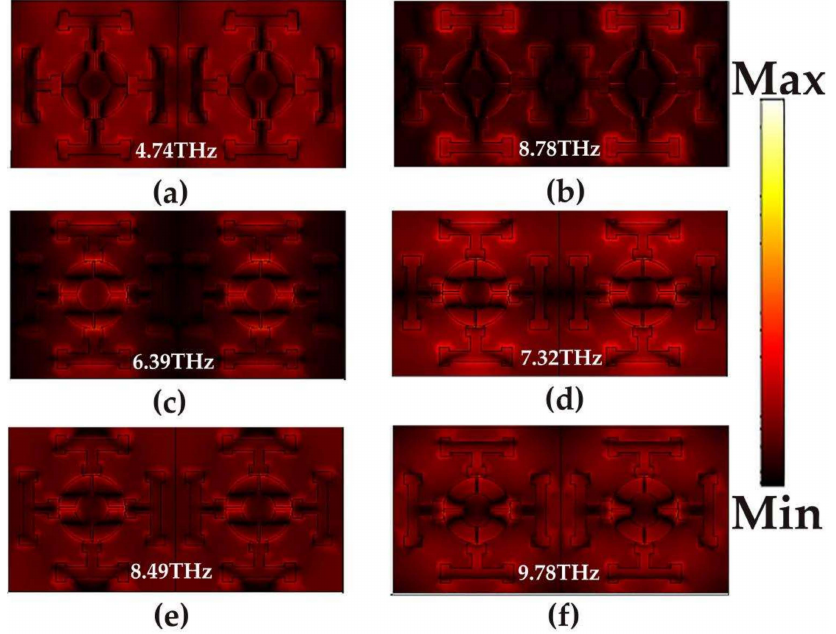
Figure 4. Electric field distribution of a broadband absorption and narrowband absorption: ( a ) 4.74 THz; ( b ) 8.78 THz; ( c ) 6.39 THz; ( d ) 7.32 THz; ( e ) 8.49 THz; ( f ) 9.78